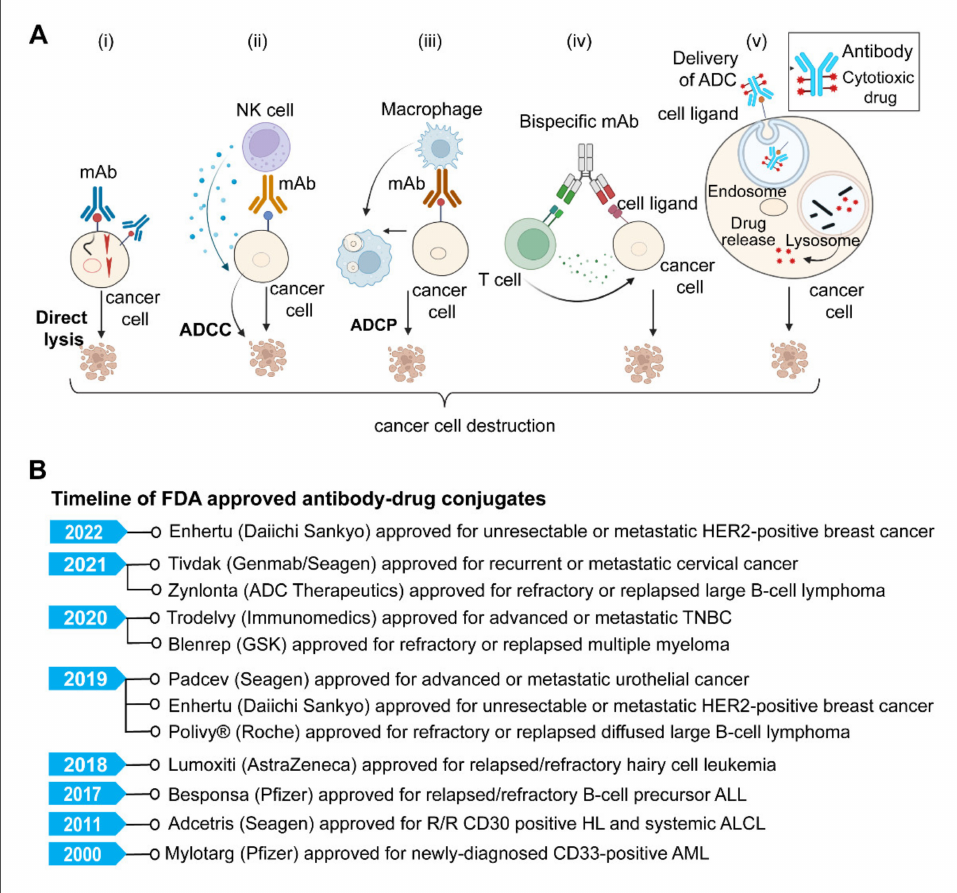
Figure 4. ( A ) Model showing various modes of action of therapeutic monoclonal antibodies used in cancer immunotherapy. ( i ) Direct killing of cancer cells; therapeutic mAbs bind to cancer cell surface receptors and facilitate killing directly by inhibiting downstream signaling pathways that are important for cellular viability and proliferation. ( ii ) Antibody-dependent cell-mediated cytotoxicity (ADCC), an immunological process (primarily mediated by NK cells) in which Fc receptor-bearing effector cells detect and kill antibody-coated target cells expressing tumor antigens on their surface. ( iii ) Antibody-dependent cellular phagocytosis (ADCP); opsonization of cancer cells by monoclonal antibodies triggers Fc receptors on macrophages, resulting in phagocytosis and subsequent killing of internalized target cells by phagosome acidification. ( iv ) A bispecific antibody acts as an adaptor molecule between the effector immune cell and the tumor cell, activation and cross-linking of effector cells (T cells) with tumor cells results in tumor cell lysis ( v ). The ADC (antibody-drug conjugate) binds to the tumor cell’s surface antigen receptor, forming an endocytosed ADC-antigen complex. The internalized complex is then processed by lysosomes, releasing the cytotoxic payload, interacting with its target, and killing the tumor cells. Created with BioRender.com ( B ) Timeline of U.S. FDA-approved antibody-drug conjugates for different cancers (Abbreviations; mAbs, monoclonal antibodies; ADCC, antibody-dependent cell-mediated cytotoxicity; ADCP, antibody-dependent cellular phagocytosis; ADC, antibody-drug